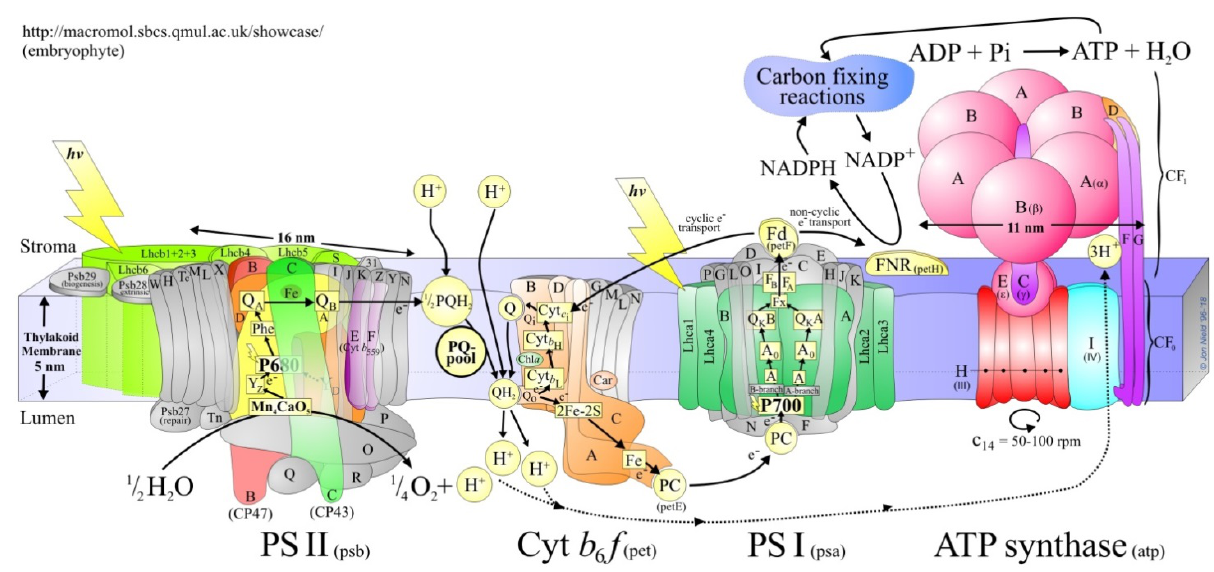
Fig.1 . Multienzyme complexes in photosynthetic membrane. The arrows show the paths of electron transfer. (Jon Nield, http://macromol.sbcs.qmul.ac.uk/showcase/)